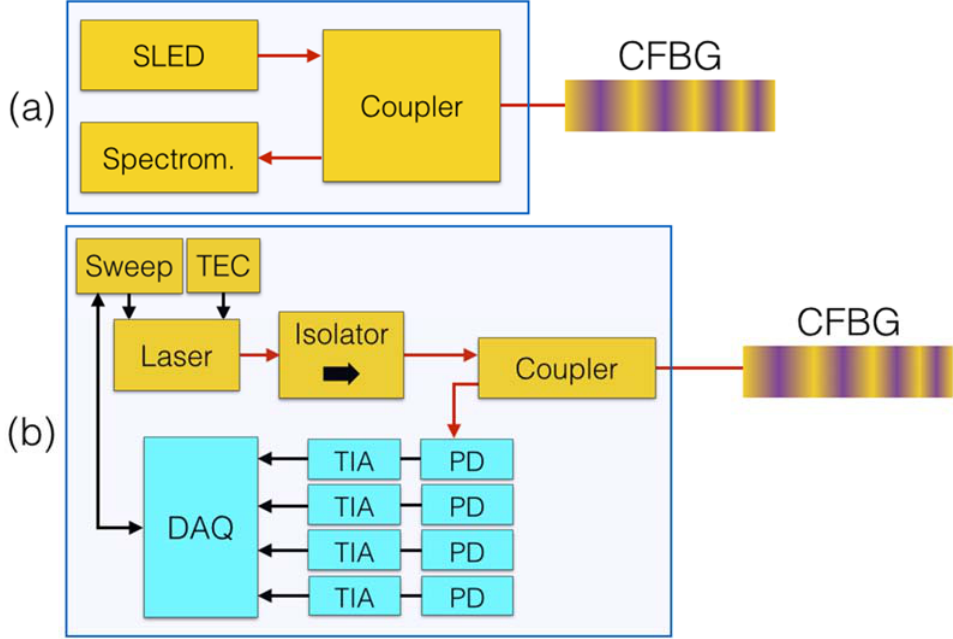
Figure 7. Schematic of CFBG interrogators, sketched as single ‐ channel systems. ( a ) White light setup based on a spectrometer; ( b ) scanning laser based setup.